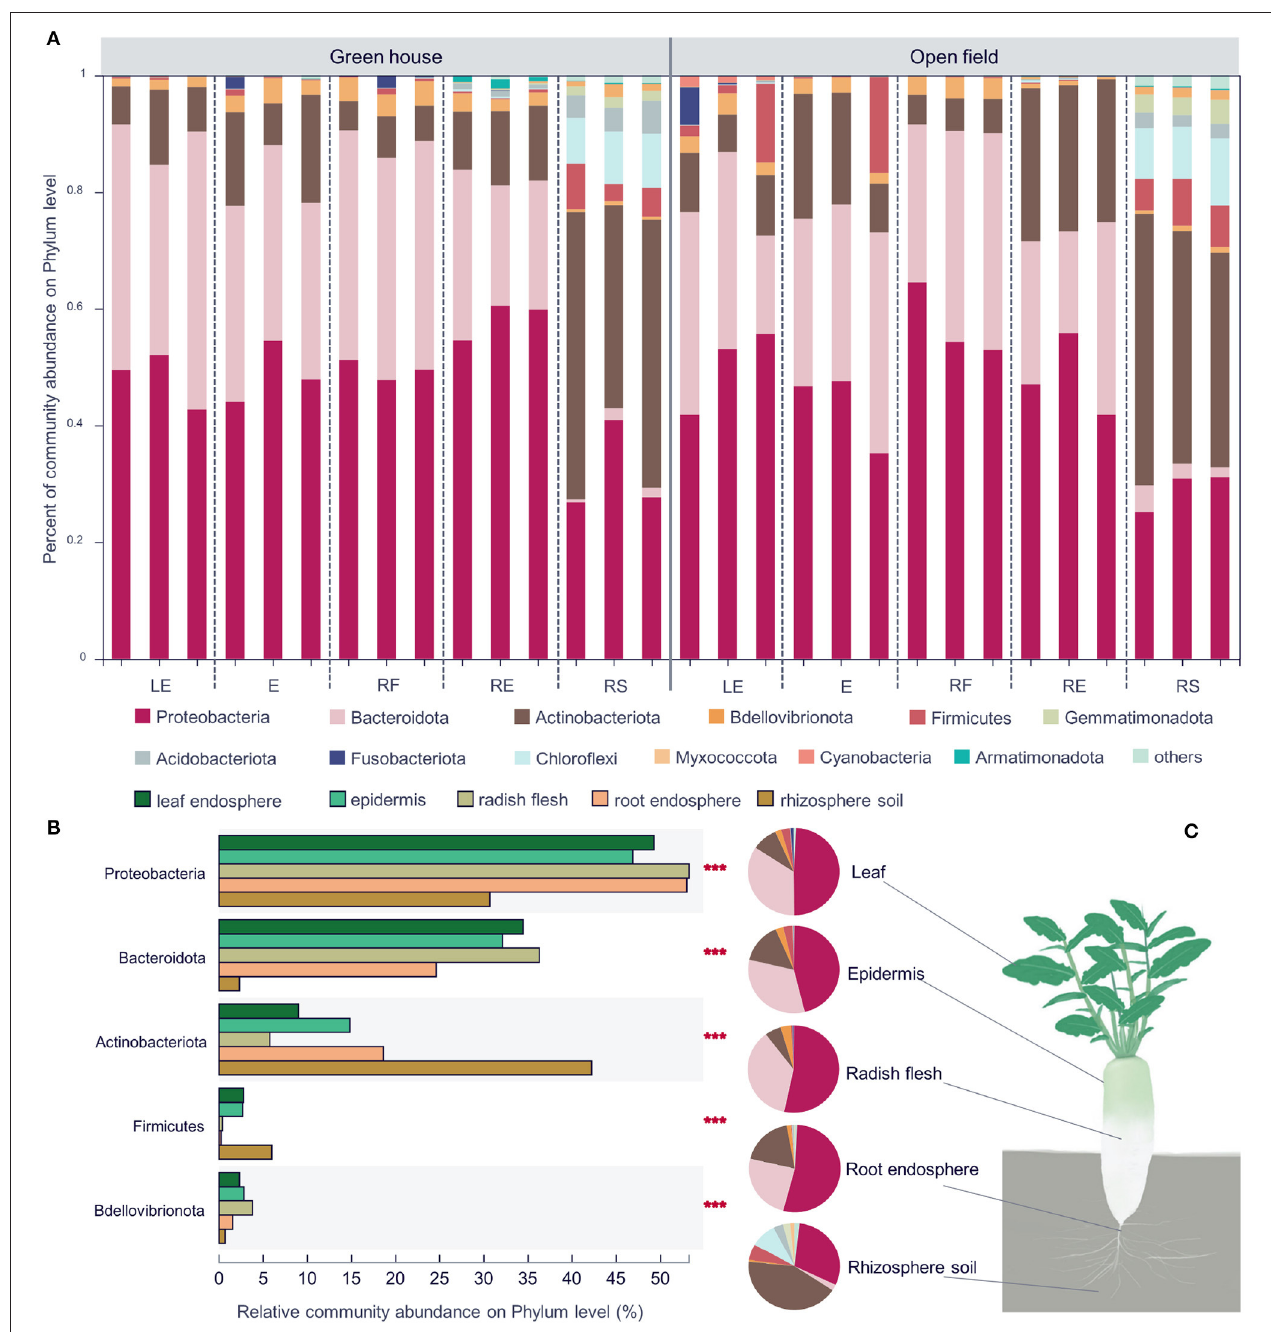
FIGURE 3 | Community composition of different white radish ecological compartments at the phylum level (A) . Significant differences in the abundances of the top five phyla (B) . The major contributing phyla of rhizosphere soil, root endosphere, radish epidermis, leaf endosphere, and radish flesh are shown in different colors. Pie chart of different compartments. Different colors indicate different phyla (C) , and the area of the pie indicates the percentage of the taxa. Significant differences in the different groups were evaluated with the Kruskal–Wallis H -test, n = 12, in each group. LE, leaf endosphere; E, epidermis; RF, radish flesh; RE, root endosphere; RS, rhizosphere soil. *** P <